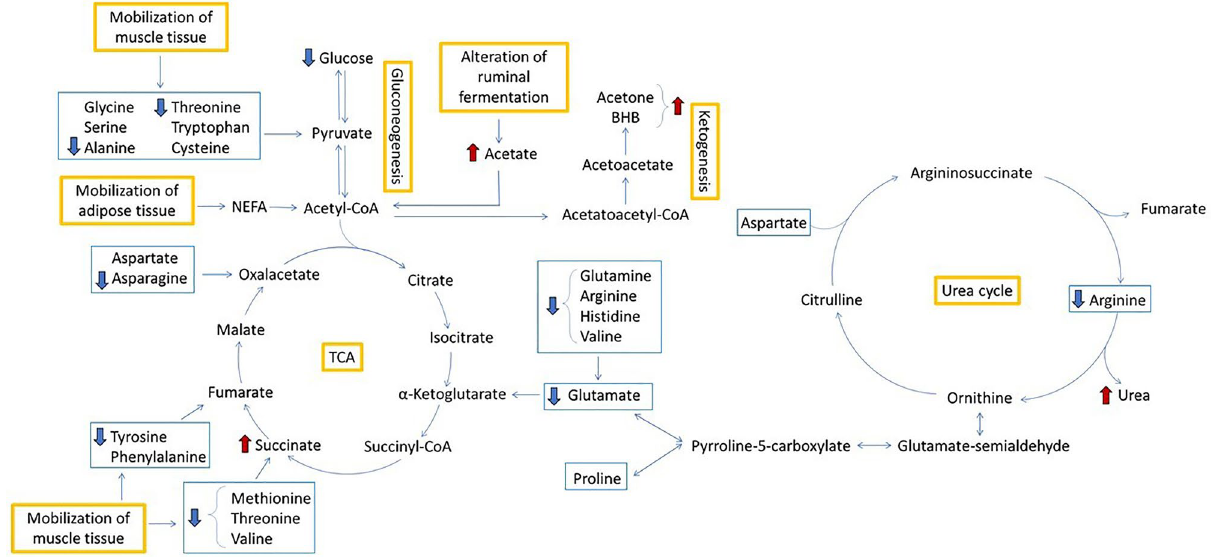
Figure 1. Metabolites changes in group HYP (n = 18; BHB ≥ 0.80 mmol/L) related to tricarboxylic acid cycle (TCA) and urea cycle. Blue rectangles are used to identify amino acids and orange rectangles are used to identify metabolic processes; blue arrows indicate a decrease in metabolite concentration while red arrows indicate an increase in concentration.